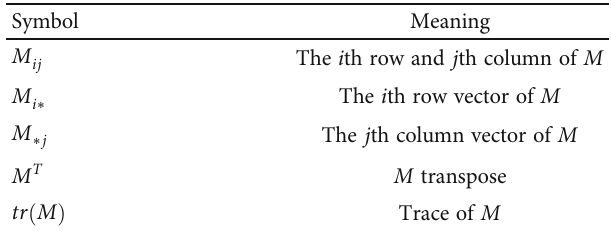
Table 1: Notations of this paper.